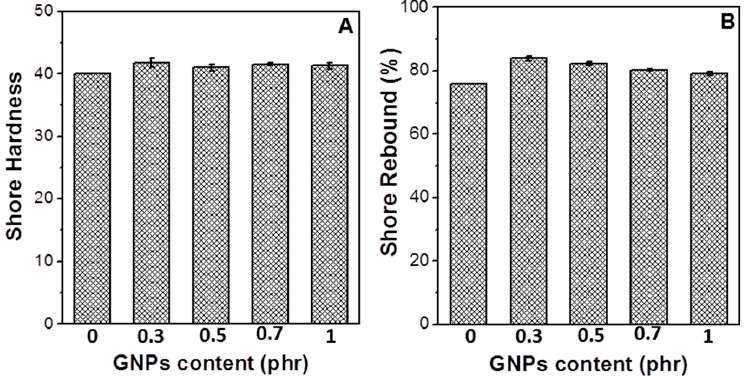
Figure 8. ( A ) Shore hardness and ( B ) shore rebound of the control samples and the GNPs/natural rubber composites. Table 2. A summary of the mechanical properties of the GNPs/natural rubber composite.